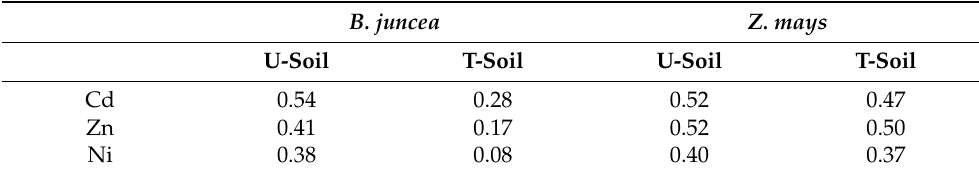
Table 1. Translocation factor of Cd, Zn, and Ni for B. juncea and Z. mays in original, untreated soil (U-soil) and compost-treated soil